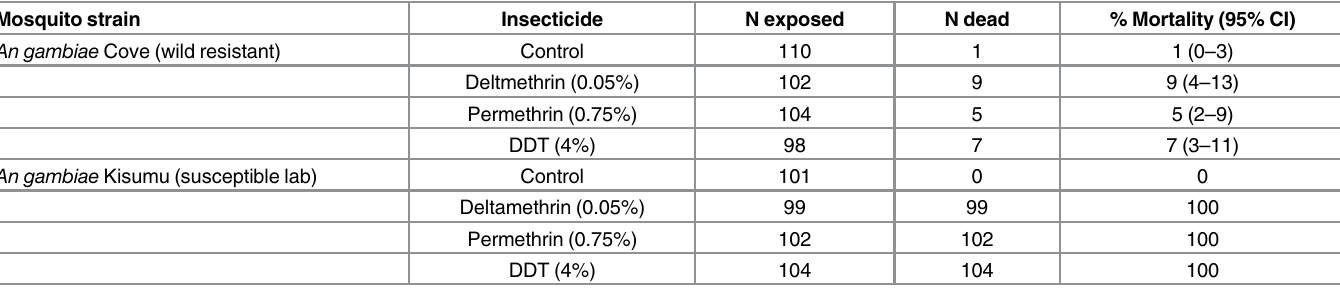
Table 1. Mortality of wild An gambiae sl from Cove in WHO resistance bioassays. Mosquito strain Insecticide N exposed % Mortality (95% CI)